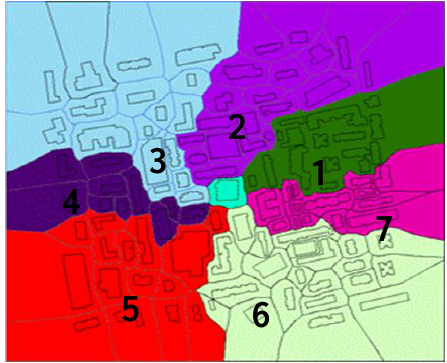
Figure 3. The result of visual domain segmentation